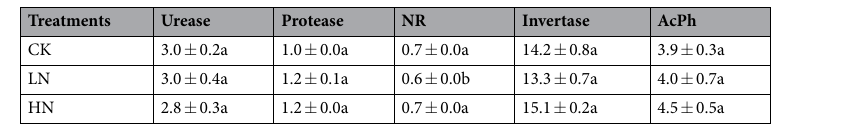
Table 4. Results of repeated measures ANOVA of soil enzyme activities ( μ mol g − 1 h − 1 , Mean ± 1 SE, n = 3). The soil samples were taken from the organic top layer (about 0–10 cm). NR: nitrate reductase; invertase: β - Fructofuranosidase; AcPh: acid phosphatase. Different letters indicate significant differences among different treatments (Repeated measures ANOVA with Fisher’s LSD test, α =